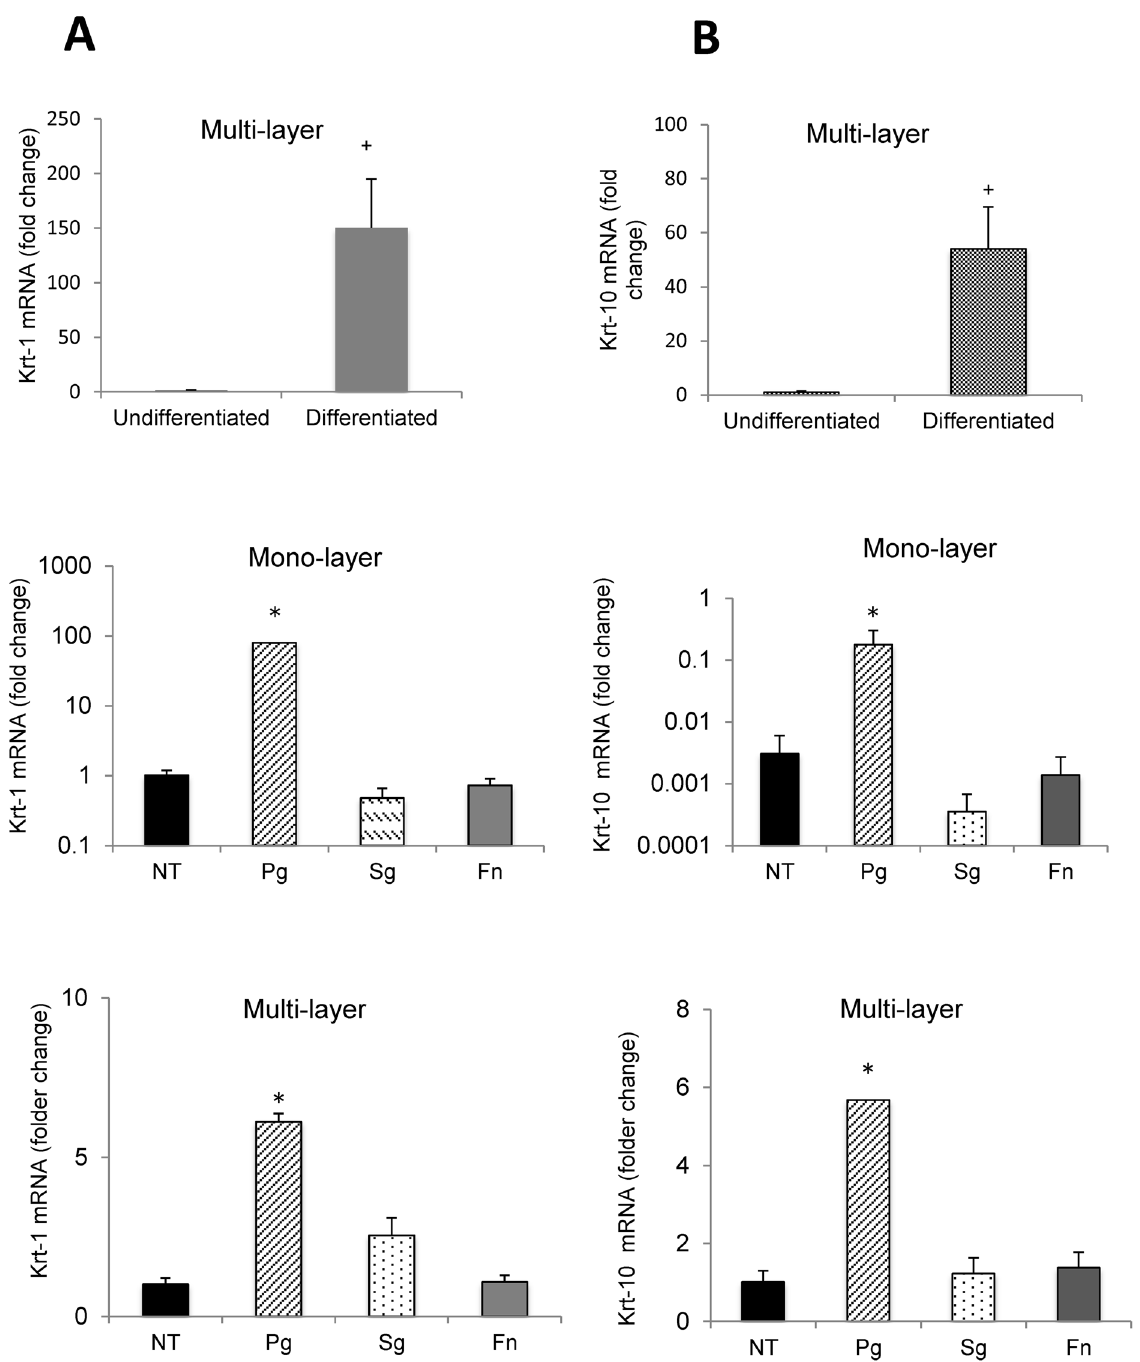
Figure 3. P.gingivalis but not F.nucleatum or S.gordonii induces expression of differentiation markers. Primary human gingival epithelial cell cultures were incubated with or without exposure to an air-liquid-interface to induce differentiation and then challenged with P. gingivalis (Pg), S. gordonii (Sg), or F. nucleatum (Fn) at 2 6 10 8 /cm 2 for 24 hrs. mRNA levels of keratin-1 or keratin-10 were measured by real-time PCR. + Significant difference between undifferentiated and differentiated cells (P , 0.05). * Significantly different from matched control (P ,